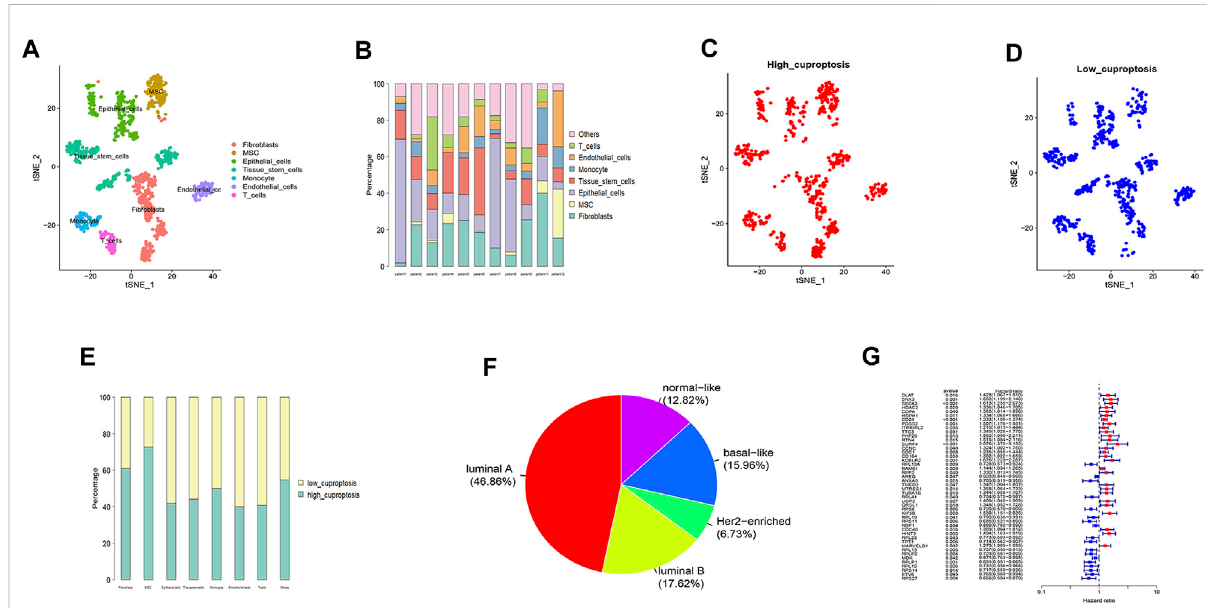
FIGURE 2 Single-cell sequencing analysis (A,B) , distribution of high_cuproptosis cells and low_cuproptosis cells (C,D,E) , subgroup analysis (E) , and univariateCOX analysis (G) . (A) Single-cellsequencing analysis oftheGSE168410 dataset ( n =11).Accordingto thesurfacemarkergenes ofdifferent cell types, the cells were annotated as Fibroblasts, MSC, Epithelial_cells, Tissue_stem_cells, Monocyte, Endothelial_cells, and T_cells. (B) The cell ratiosofeverysampleatthesingle-celllevelafterqualitycontrol. (C,D) Distributionofhigh_cuproptosiscellsandlow_cuproptosiscells. (E) The distribution of high_cuproptosis cells and low_cuproptosis cells in each cell cluster was relatively uniform. (F) The BC patients were divided into fi ve subgroups,includingluminalA(46.86%),luminalB(17.62%),Her2-enriched(6.73%),basal-like(15.96%),andnormal-like(12.82%). (G) UnivariateCOX analysis of the TCGA cohort. We selected 47 genes with prognostic signi fi cance ( p < 0.05). Blue represented low-risk CDRG and red represented high-risk